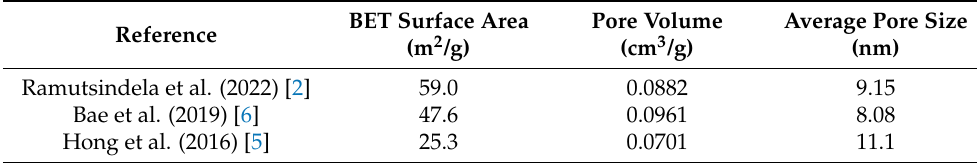
Table 1. Pore characterization of raw iron ore FTS catalysts a . Reference